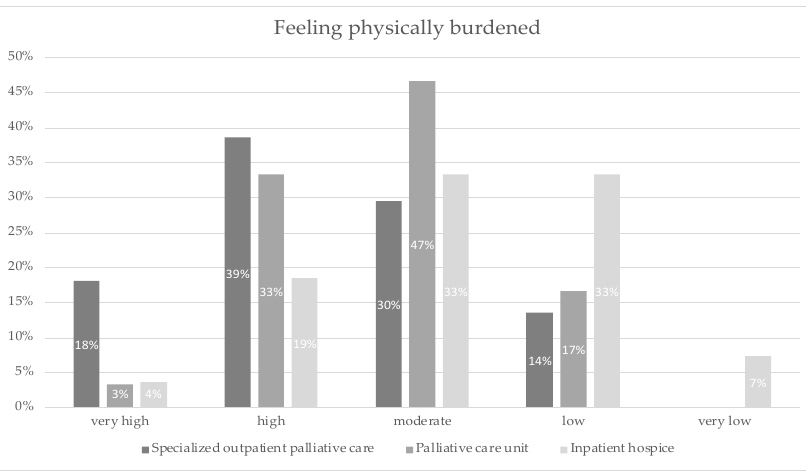
Figure 2. Feeling mentally burdened was measured when asked: “How do you rate your psycho- logical burden at the moment?”; the response options that participants could choose from were: very high, high, moderate, low, and very low.